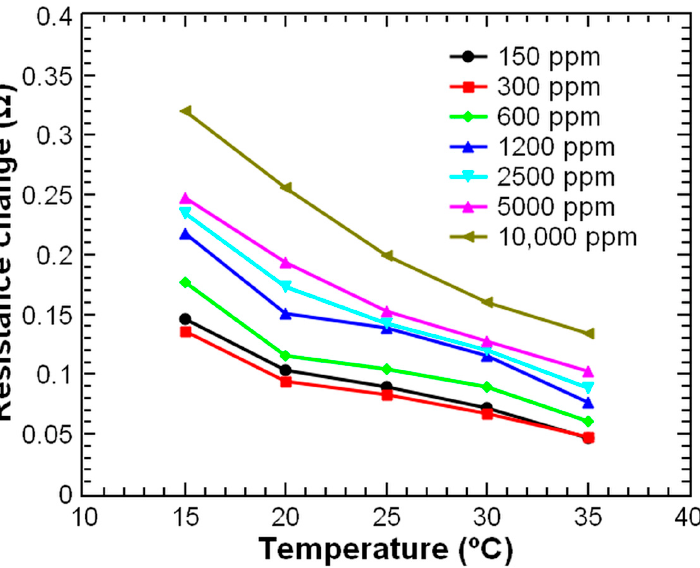
Figure 6. Temperature dependence of the steady ‐ state sensor response for different concentrations of CO 2